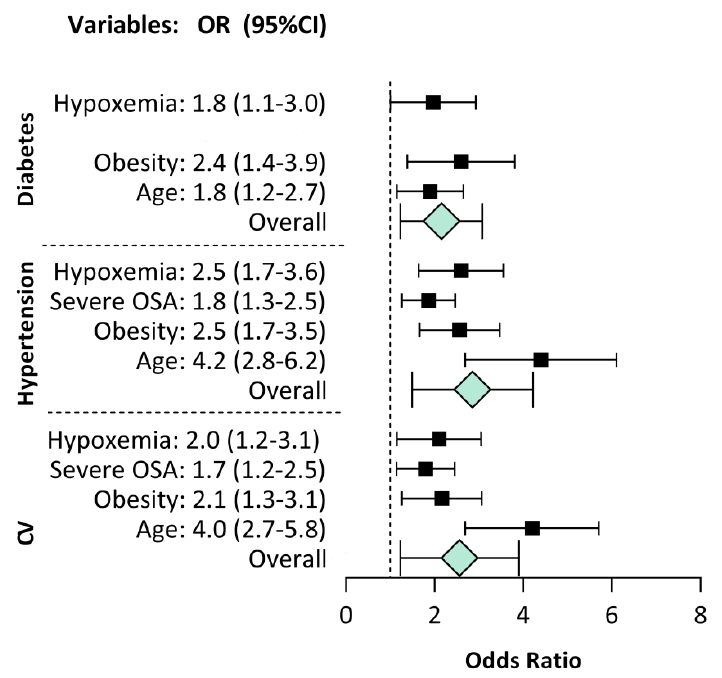
Figure 1. Forest plot of the odds ratio (OR) for the risk of comorbidities (cardiovascular (CV) disease, hypertension and diabetes) related to severe obstructive sleep apnoea (OSA) and nocturnal hypoxemia in the univariate analysis.